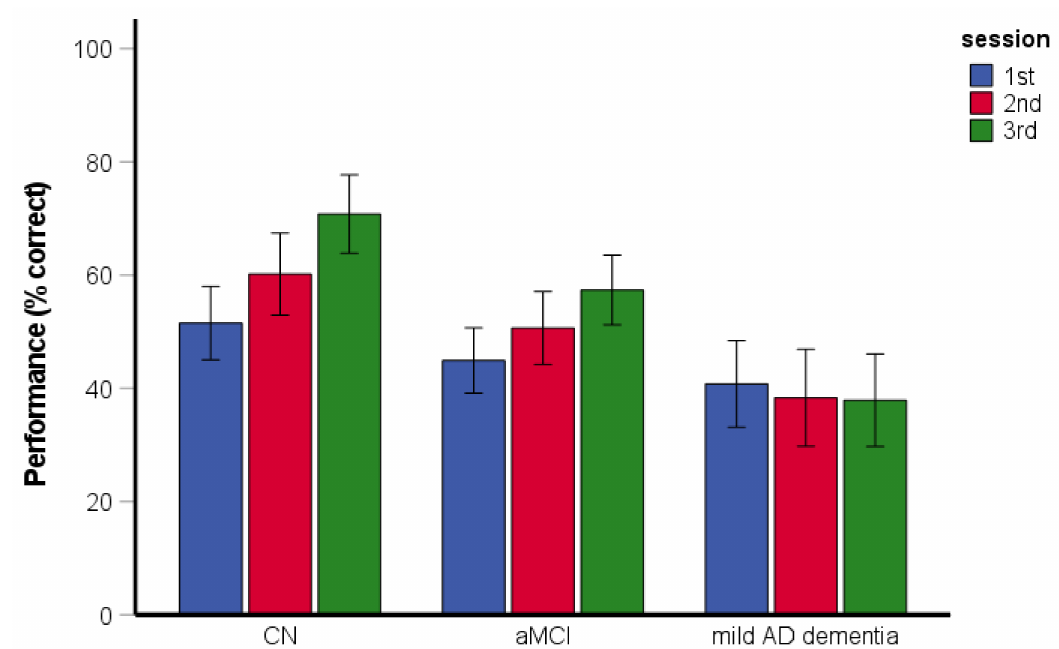
Figure 5. Route-retracing task—spatial navigation performance and learning across the sessions. CN, cognitively normal; aMCI, amnestic mild cognitive impairment; mild AD dementia, mild Alzheimer’s disease